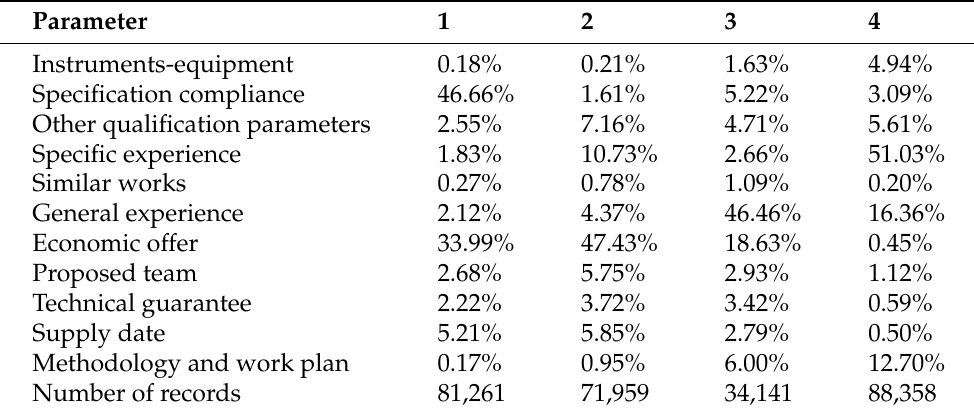
Table 3. Clusters